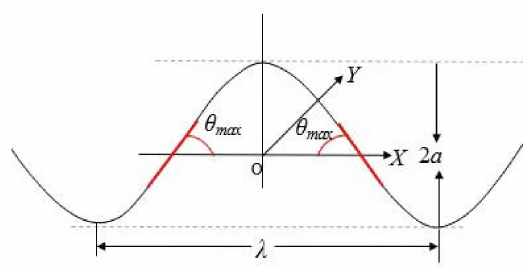
Figure 10. Schematic diagram of fiber waviness.